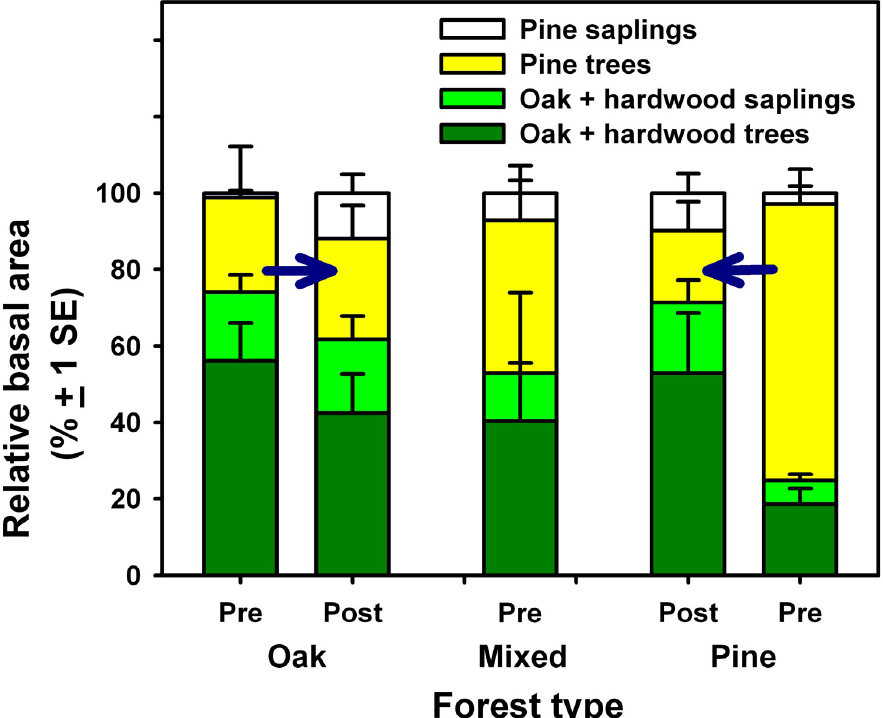
Fig 4. Relative basal area of pine and hardwood trees and saplings. Data are from the oak stand before L . dispar infestation in 2005 and following tree and sapling mortality in 2018, the mixed stand at the beginning of the study in 2005, and untreated pine-dominated areas following infestation by southern pine beetle and uninfested areas. Oaks and other hardwoods have been combined as “hardwoods”. Arrows indicate the directional changes caused by insect